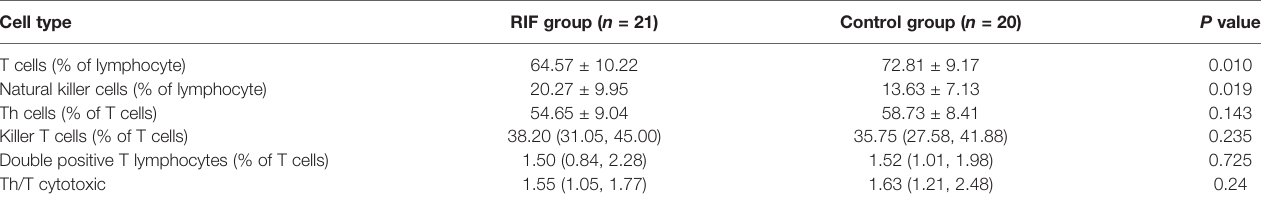
TABLE 2 | Comparisons of lymphocyte subsets between the recurrent implantation failure and control groups.